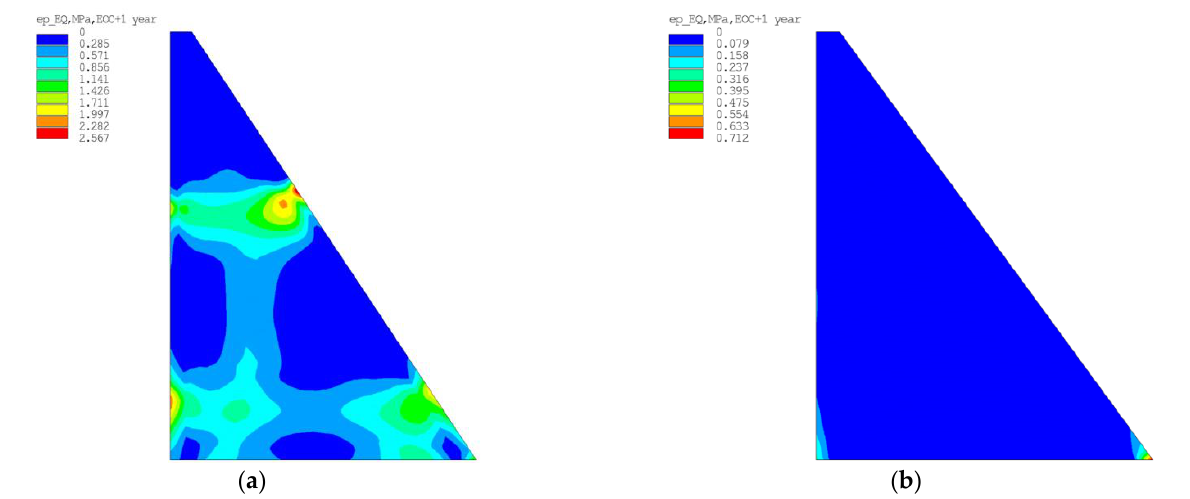
Figure 10. Results of the determination of plastic deformation in a concrete mass: ( a ) The least favorable calculation case; ( b ) The most favorable calculation case.